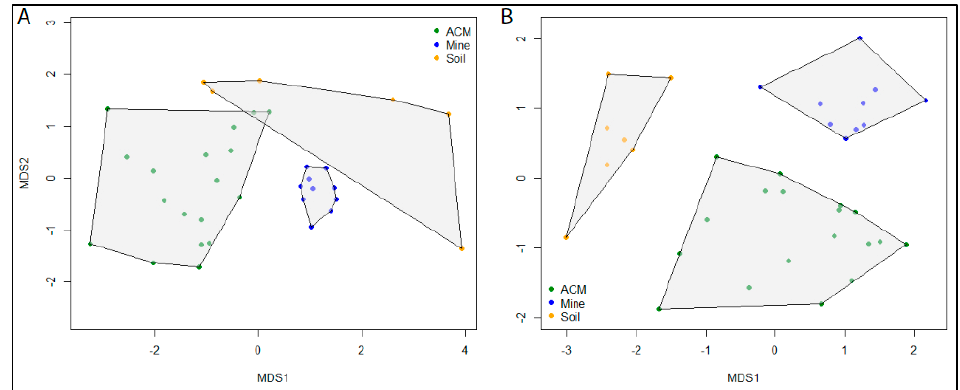
Figure 3. Ordination plots using non-metric multidimensional scaling (MDS) using Bray–Curtis dis- similarity from log(10)+1 transformed abundances from ( A ) ITS ASVs from 35 samples and ( B ) 16S ASVs from 36 samples identified by metabarcoding of ITS and 16S datasets, respectively. Samples are colour coded according to sample type: ACM (green), asbestos contaminated material; Mine tailings (blue), raw asbestos samples from mine tailings; Soil (orange), asbestos contaminated soil